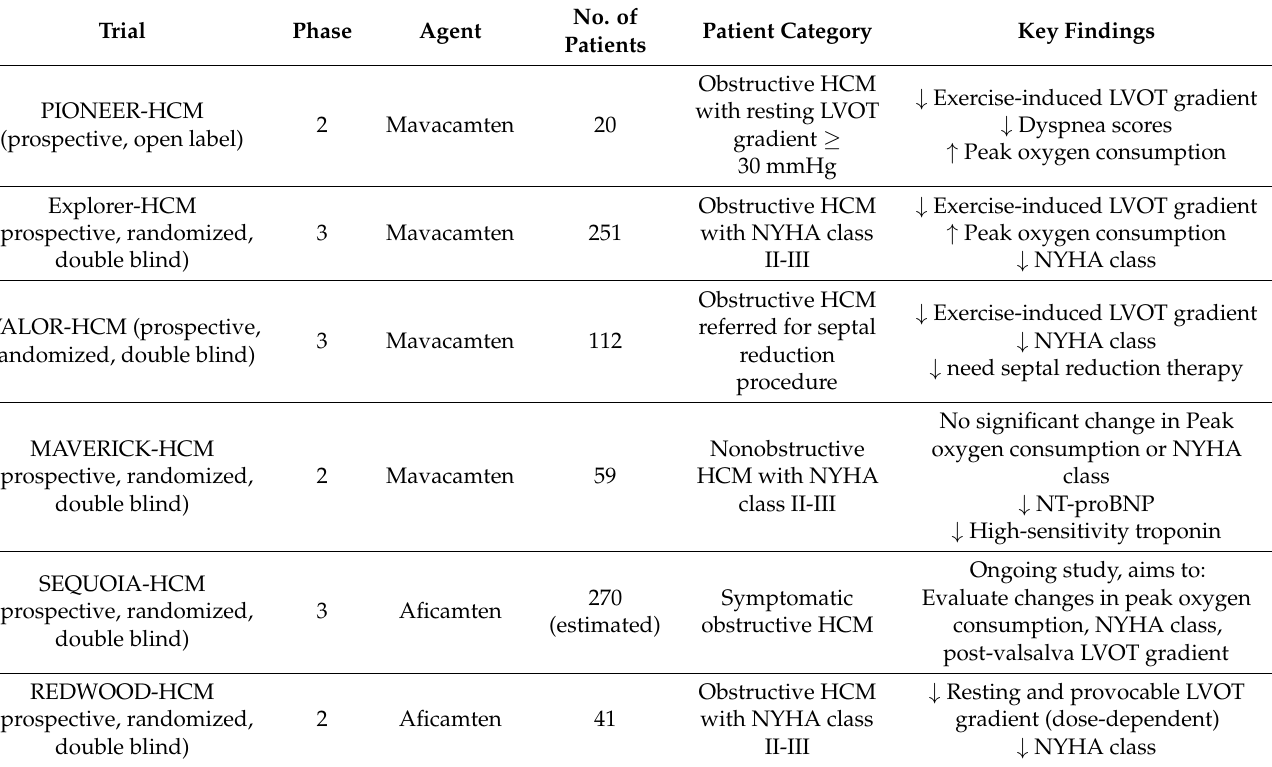
Table 2. Highlights related to trials on novel therapeutic approaches for HCM.